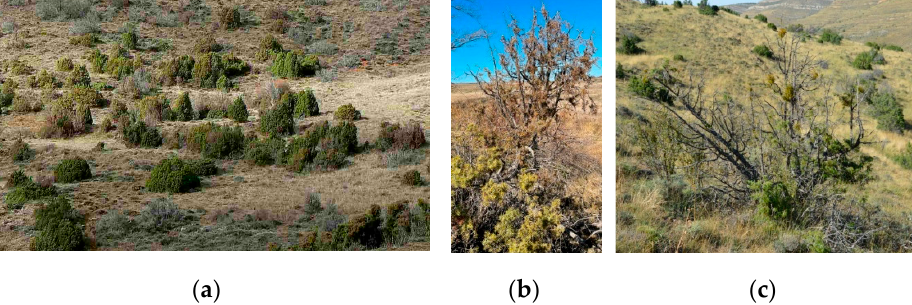
Figure 1. Views of ( a ) a common juniper population affected by dwarf mistletoe with abundant dead or declining individuals, and junipers ( b ) moderately and ( c ) severely infected by dwarf mis- tletoe.